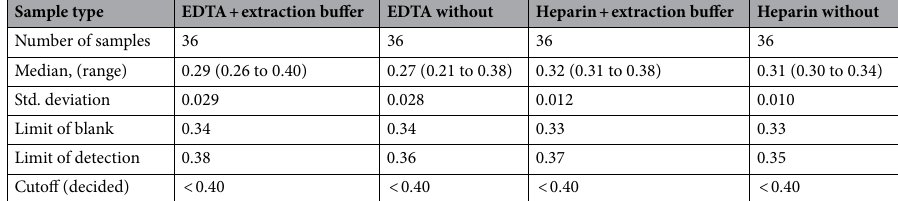
Table 1. Determination of the limit of detection of the N-antigen for the Elecsys ECLIA assay.